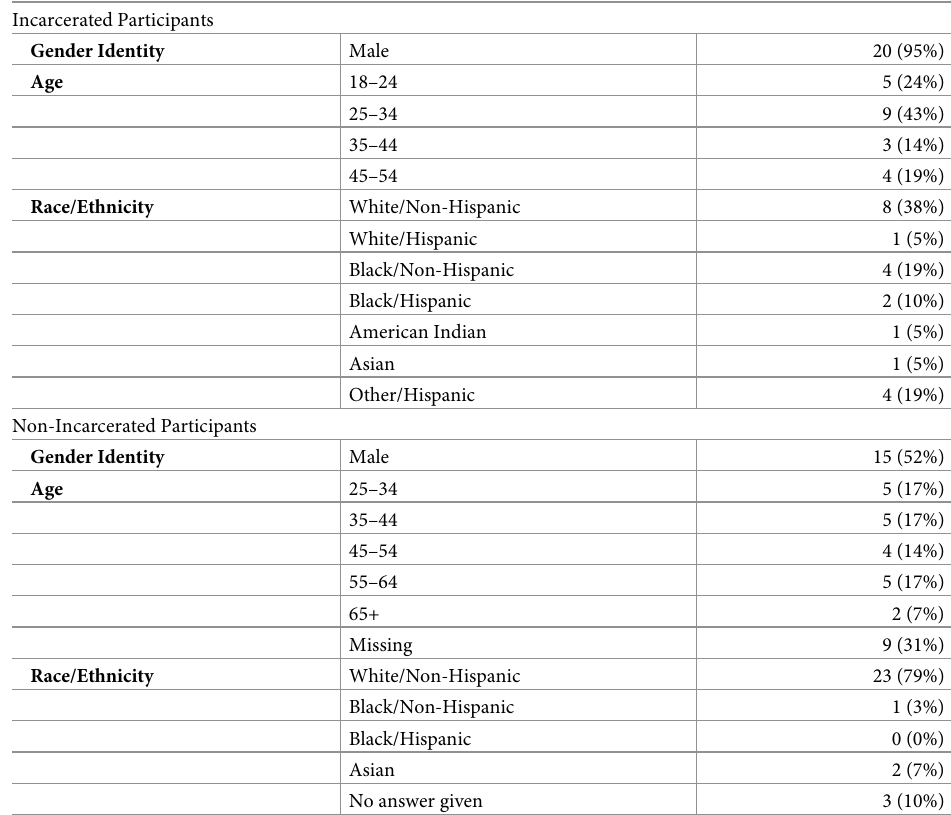
Table 2. Participant demographic